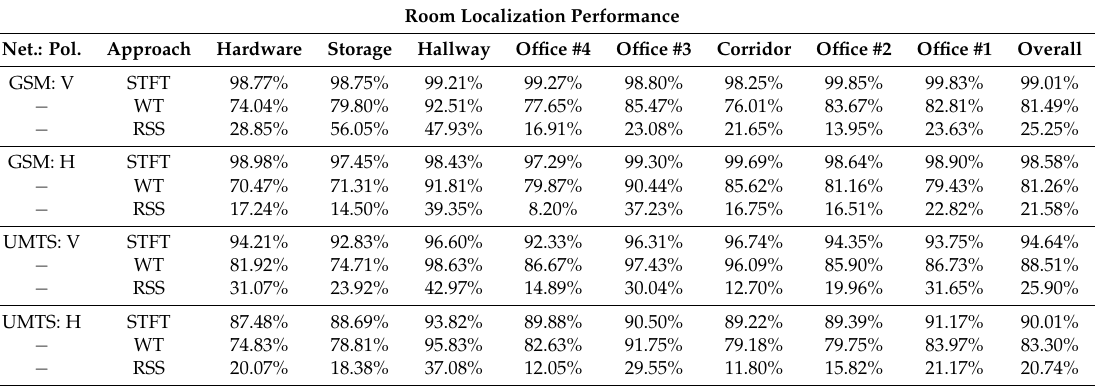
Table 2. Experimental W K NN Room Localization Performance for UMTS and Global System for Mobile Communication (GSM) Non-Cooperative